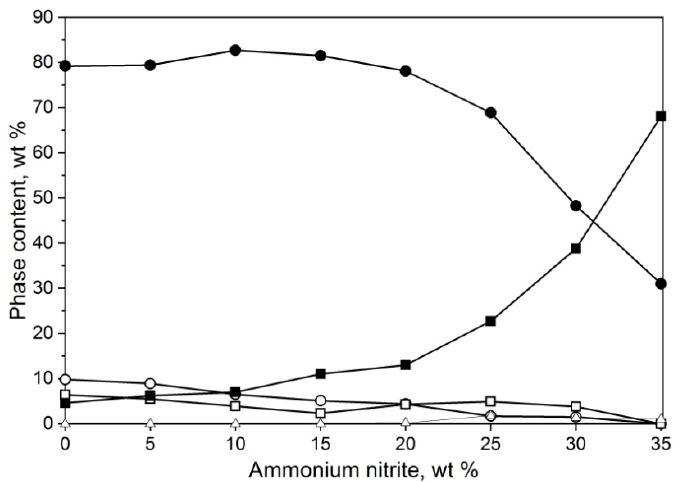
Figure 4. Phase composition of powders obtained by the means of SHS method from mixtures containing different amount of ammonium nitrite, γ -AlON ( ● ), Al 2 O 3 ( ○ ), AlN ( □ ), Al ( ■ ), and Al 7 O 3 N 5 ( ∆ ).